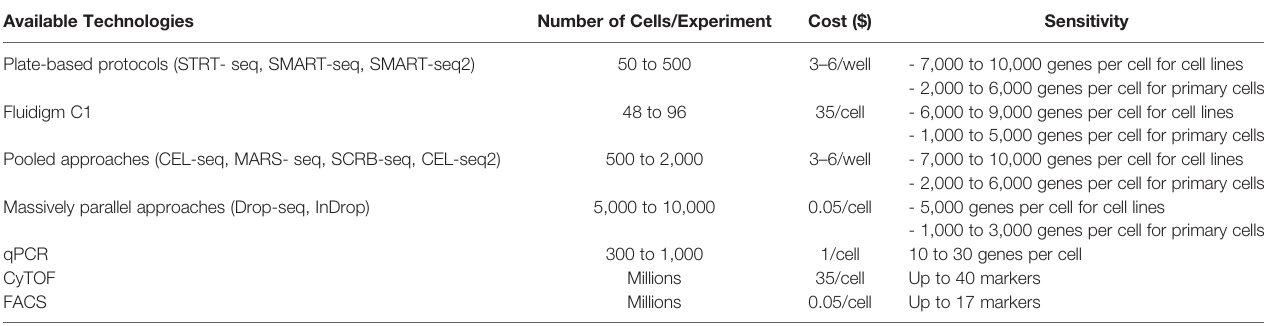
TABLE 2 | Current approaches for scRNA-seq and their practical advantages and limitations. Available